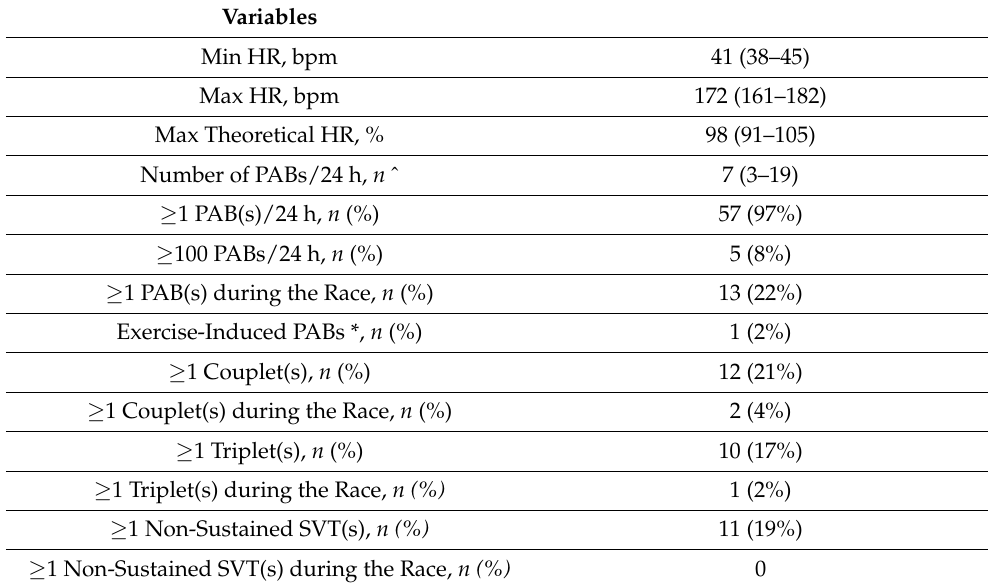
Table 3. Ambulatory ECG monitoring data obtained the day before the race and during the entire duration of the race. Data obtained at rest and during the race were reported separately.